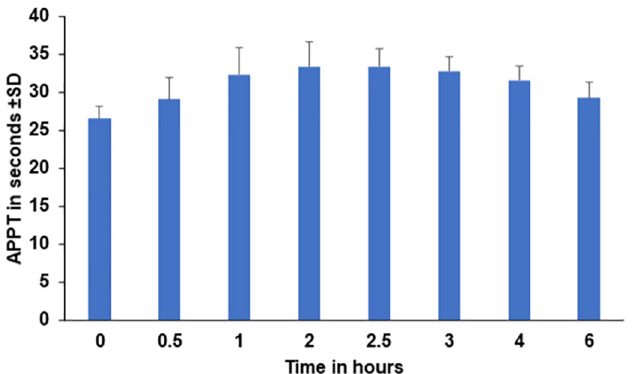
Fig 4. Post-injection changes in activated partial thromboplastin time (APTT) after the Day 29 injection of ILB 1 .